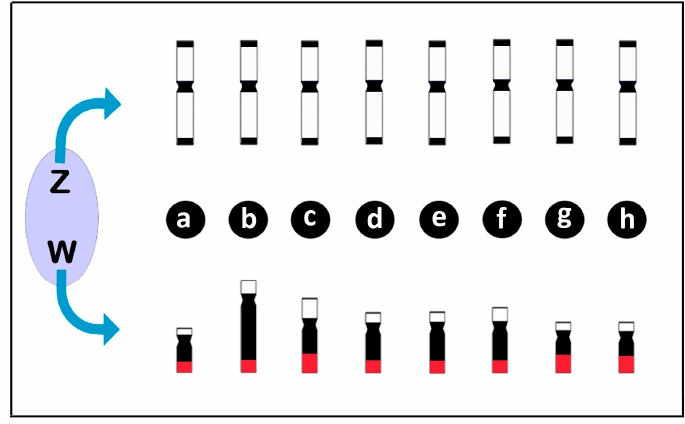
Figure 5. Diagrams illustrating the differentiation of the Z and W chromosomes in Triportheus species highlighting the conserved pattern of the Z chromosome in relation to morphology, size and heterochromatin content (in black), in opposite to the divergent patterns of the W chromosome among species. Note that the W chromosome varies in size, morphology, and heterochromatin content, but carries a 18S rDNA cluster on the long (q) arms (in red) in all species. ( a ) T. albus ; ( b ) T. auritus ;